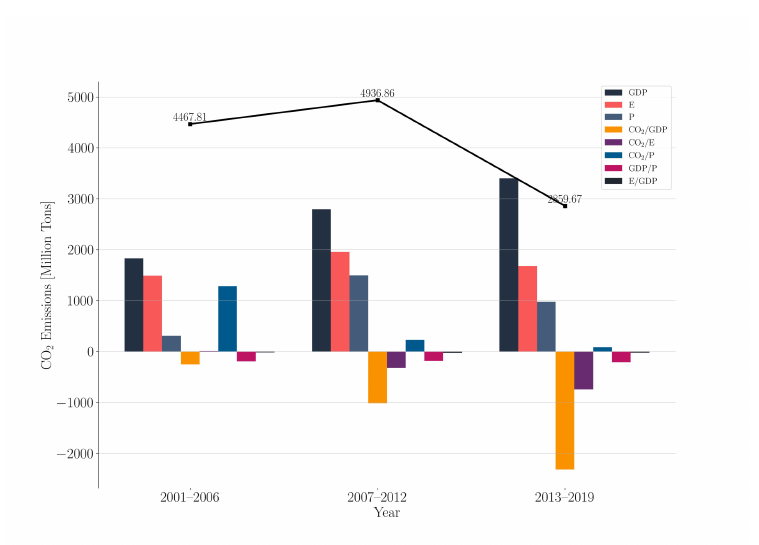
Figure 5. Staged factor decomposition results of carbon emission evolution of the logistics